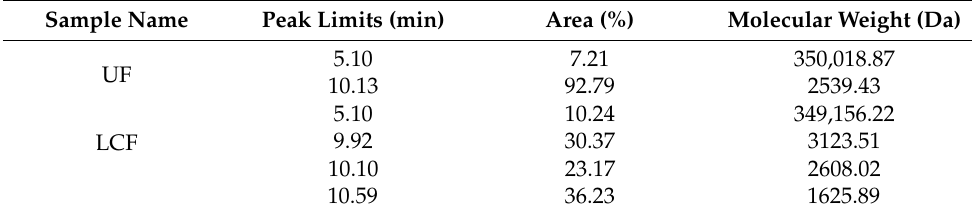
Table 2. Distribution of molecular weights of polypeptides in UF and LCF.